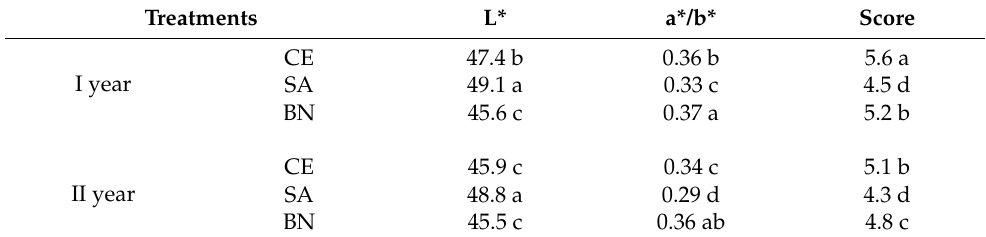
Table 4. The effect of Locations x N fertilization rates and Years x Locations on L*, a*/b*, and scores (by expert evaluators) of cured leaves. For the explanation of the index, see Materials and Methods section. Table 4. Cont.